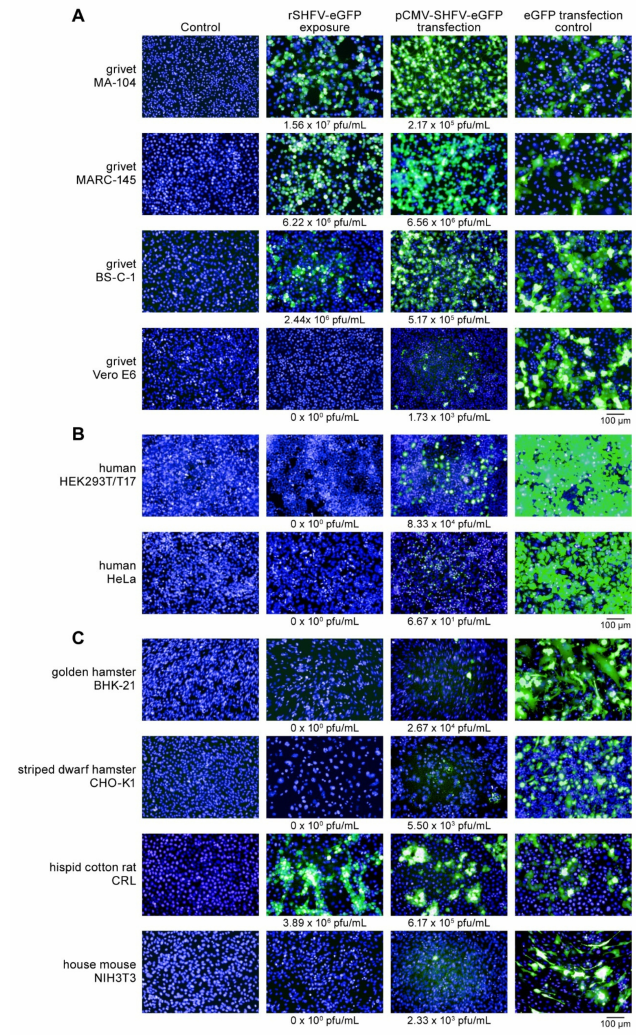
Figure 4. Cellular tropism of simian hemorrhagic fever virus (SHFV): Recombinant wild-type SHFV expressing enhanced green fluorescent protein-expressing (rSHFV-eGFP) infects hispid cotton rat lung (CRL) cells. ( A ) Grivet cells, ( B ) human cells that are not part of the human NCI-60 cancer cell line panel, and ( C ) rodent cells were exposed to rSHFV-eGFP at a multiplicity of infection of 3. Tissue culture supernatants were harvested at 72 h post-exposure, cells were counterstained with Hoechst 33342, and high-content images of exposed cells or mock-infected cells were taken. Supernatants of virus- exposed cells were also subjected to plaque assay; obtained titers are printed beneath the images. Uninfected cells were also transfected with pCMV-SHFV-eGFP or a control plasmid expressing eGFP only. At 48 h post-transfection, cells were counterstained with Hoechst 33342, high-content images were taken, supernatants were harvested, and viral titers were measured by plaque assay; obtained titers are indicated beneath the